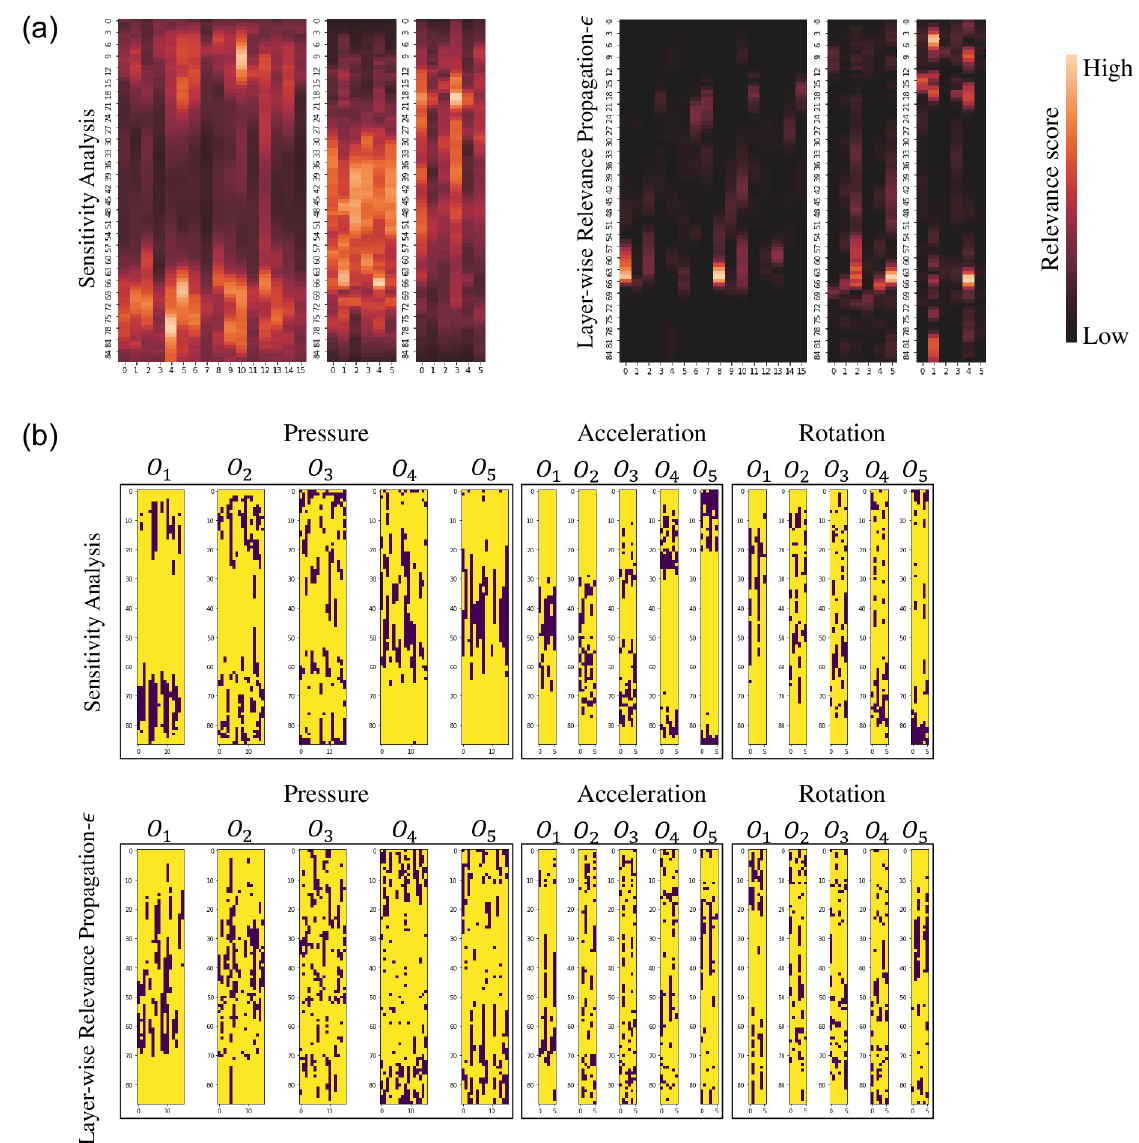
Fig 10. Averaged relevance score heat maps and the their occluding positions for O 1 ��� O 5 of SA and LRP- � . In each heatmap, the x-axis and y-axis indicate features of each sensor and time-stamps of each unit step, respectively. (a) Common attribution maps. (Left: SA, Right: LRP- � ). (b) Occluding positions ( O 1 , ��� , O 5 ) for all modal inputs. (Top: SA, Bottom: LRP- � ).